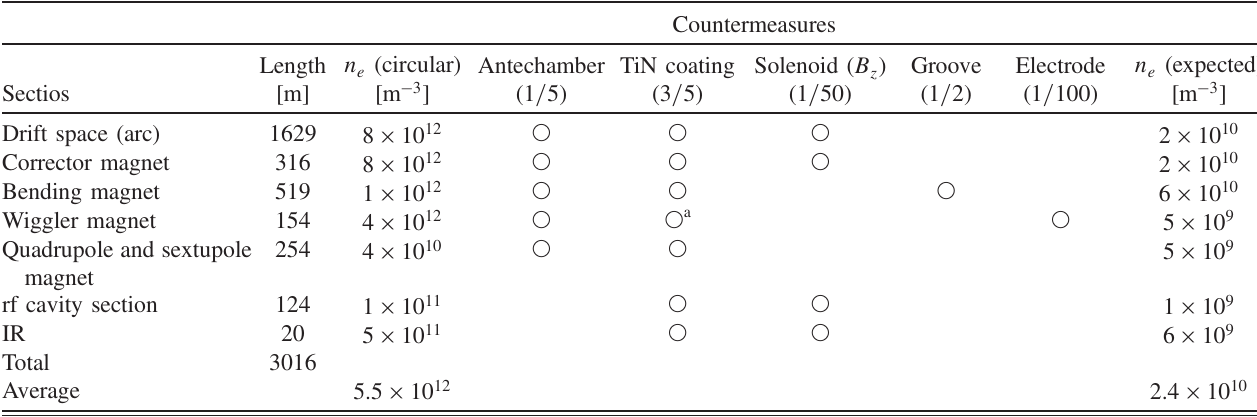
TABLE I. Countermeasures used to minimize the ECE in the SuperKEKB LER. The circles indicate the countermeasures applied for each main section in the ring [22,24]. Abbreviations: rf cavity section: beam pipes around rf cavities; IR: interaction region; n e (circular): electron density expected for circular beam pipe (copper); n e (expected): electron density expected after applying countermeasures; Antechamber: antechamber scheme; Solenoid: solenoid winding, manifested as a magnetic field in the beam direction ( B z ); Groove: beam pipe with grooves; Electrode: beam pipe with clearing